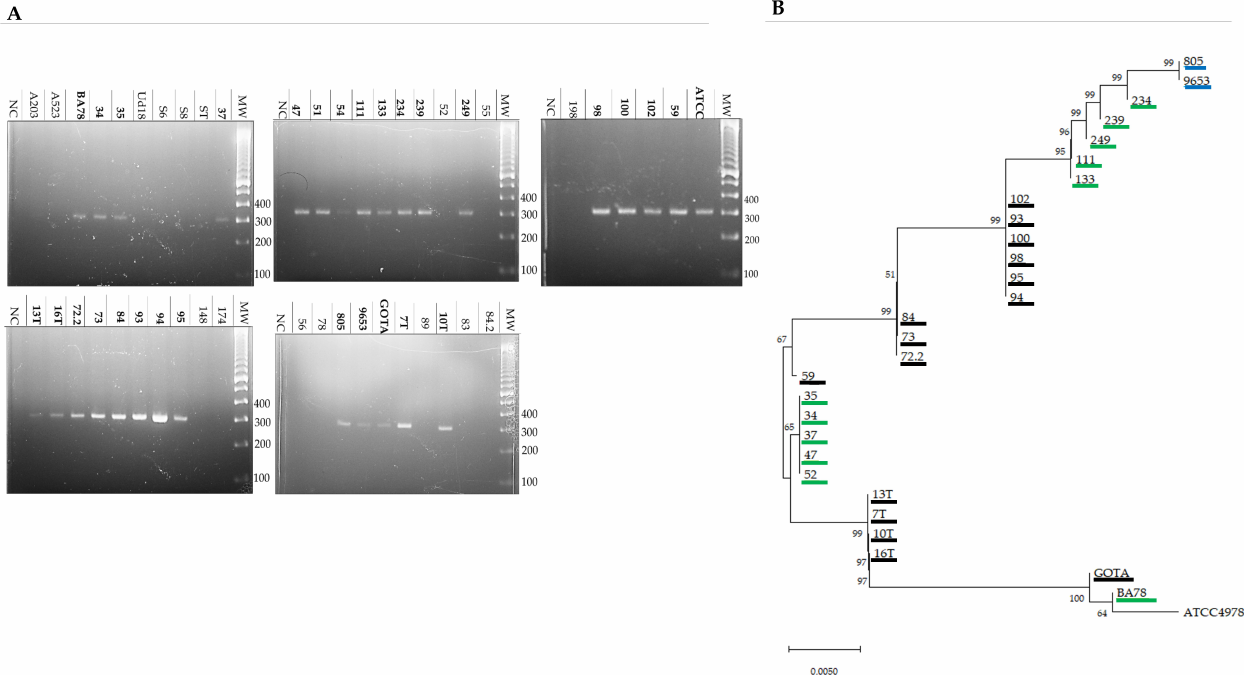
Figure 3. Identification of GUDIV-103 from Ureaplasma diversum isolates and phylogenetic analysis. ( A ) Agarose gel electrophoresis of PCR-amplified GUDIV-103 fragment using DNA extracted from 46 U. diversum strains from different Brazilian states. MW: molecular weight marker TrackIt 100 bp ladder (Invitrogen, S ã o Paulo, Brazil). NC (negative control): All elements of the reaction except the target DNA. ( B ) Phylogenetic tree generated using the neighbour-joining method with a Tajima–Nei distance matrix (MEGA-X version 4.1) following the alignment of GUDIV-103 sequences from U. diversum isolates and the reference strain, ATCC 49782. Strains from Mato Grosso do Sul, Bahia, and S ã o Paulo are underlined in blue, green, and black,